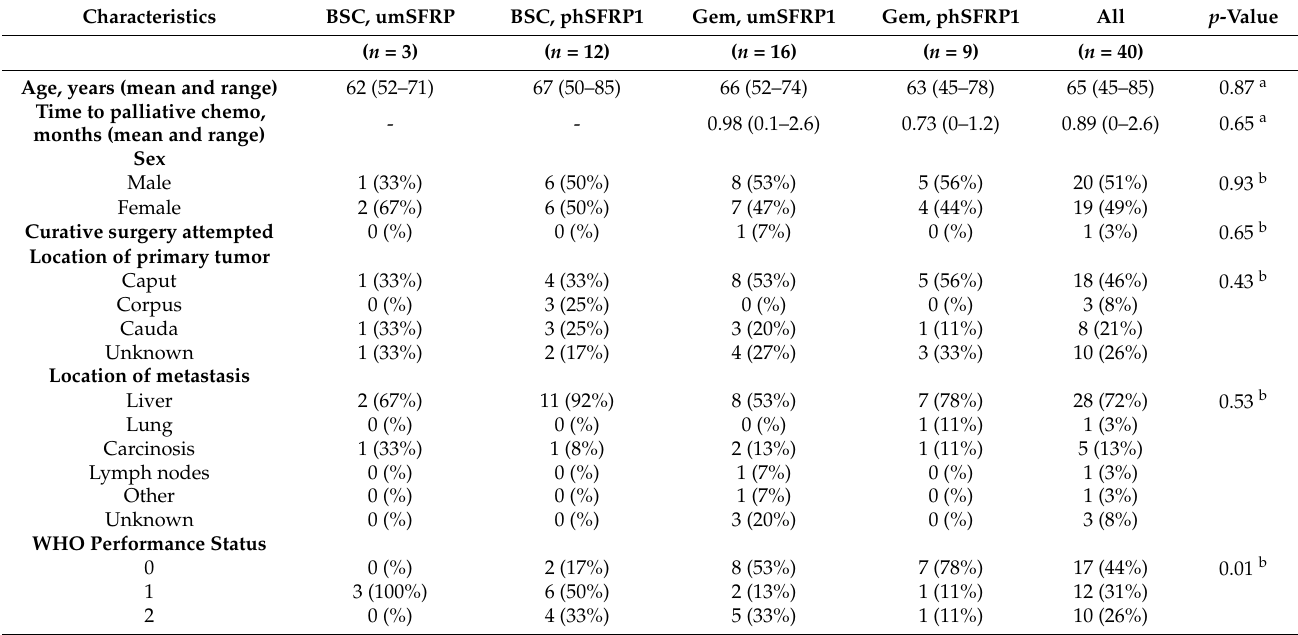
Table 1. Characteristics on PDAC patients from the discovery